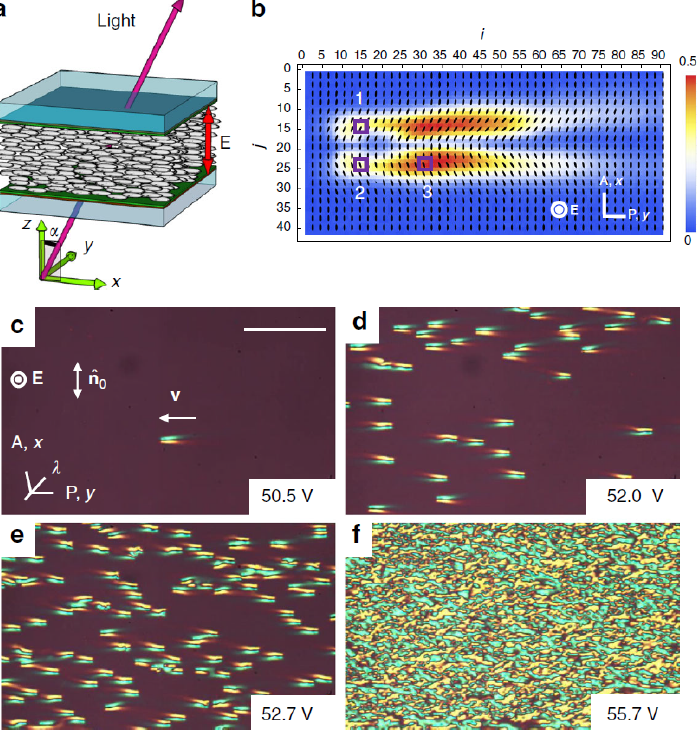
Figure 8. Director bullets in a planar nematic cell. ( a ) Cell scheme. ( b ) Transmitted light intensity map and director distortions in the xy plane within a single bullet. ( c – e ) Polarizing microscopy of the director bullets at varied voltages. ( f ) Polarizing microscopy of the electro-hydrodynamic pattern. Scale bar 200 μ m. Reprinted with permission from Ref. [99]. Copyright 2018 Nature.